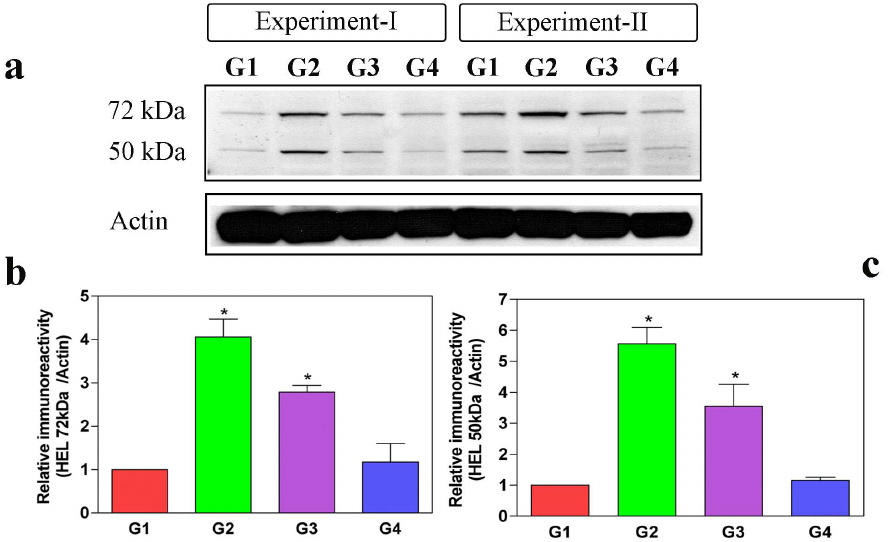
Figure 3. C-phycocyanin protects cells from free radical-mediated lipid peroxidation (LPO) induced by oxalate. To test the extent of free radical-mediated cellular damage, some oxidative stress markers have been developed and recognized suggestive of lipid peroxidation (LPO); for instance, HEL (hexanoyl-lysine adduct) is one the typical aldehyde products used as a marker of LPO. Thus, LPO was assessed by Western blotting for HEL in the lysates of MDCK cells from control (G1), oxalate alone (G2), oxalate + CP (G3) and CP alone (G4). Band intensity of HEL is prominent in oxalate-alone-treated cells (G2) at 72 kDa and 50 kDa compared to control MDCK cells (G1), whereas oxalate + CP cells (G3) showed decreased HEL band intensity relative to oxalate-treated cells (G2). The densitometric analyses were performed using a ImageJ (NIH) software. Densitometry data of 72 kDa and 50 kDa were normalized using internal control actin. Values represent mean 6 SD derived from immunoblots of all the groups from 3 experiments. The P values for HEL 72 kDa and 50 kDa of all the groups were as follows: HEL 72 kDa: G1 vs G2 (*P=0.017) and G2 vs G3 (*P=0.05); HEL 50 kDa: G1 vs G2 (*P=0.013) and G2 vs G3 (*P=0.009). P , 0.05 were considered significant (*). G1: Control; G2: Oxalate; G3: Oxalate + CP; G4: CP